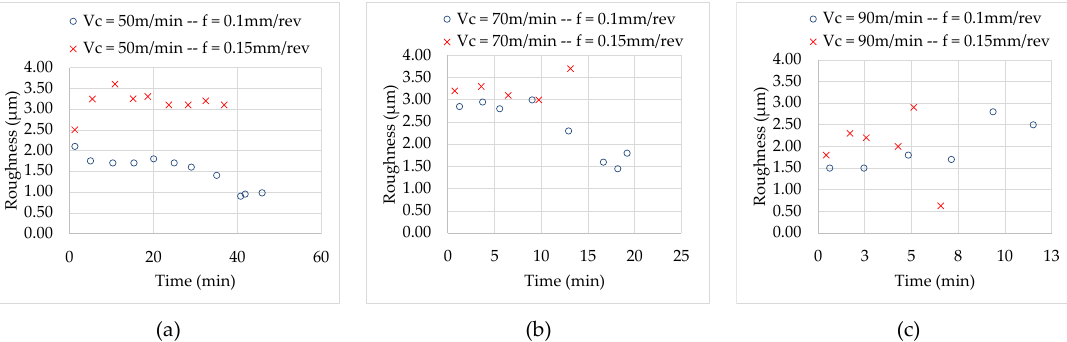
Figure 10. Machined surface roughness for Haynes 282 turning tests with high pressure cooling: ( a ) 50 m/min; ( b ) 70 m/min and ( c ) 90 m/min